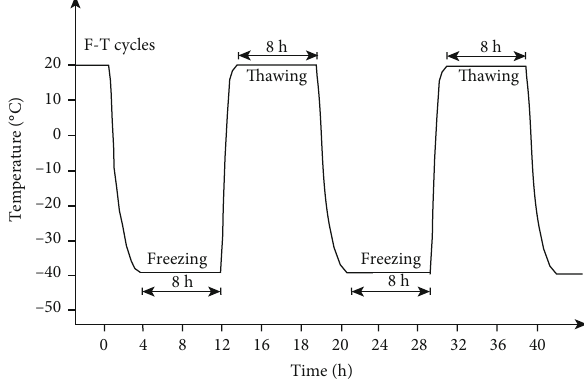
Figure 4: Freeze-thaw testing scheme for the granite